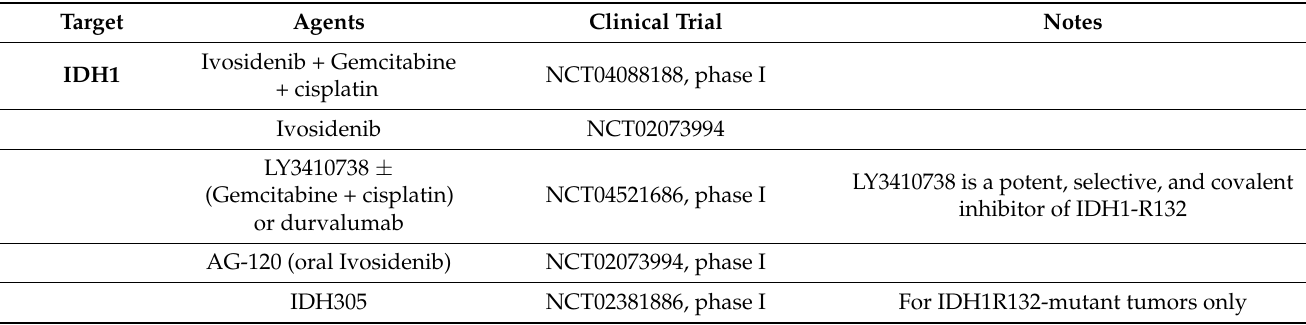
Table 2. Ongoing targeted therapy trials in